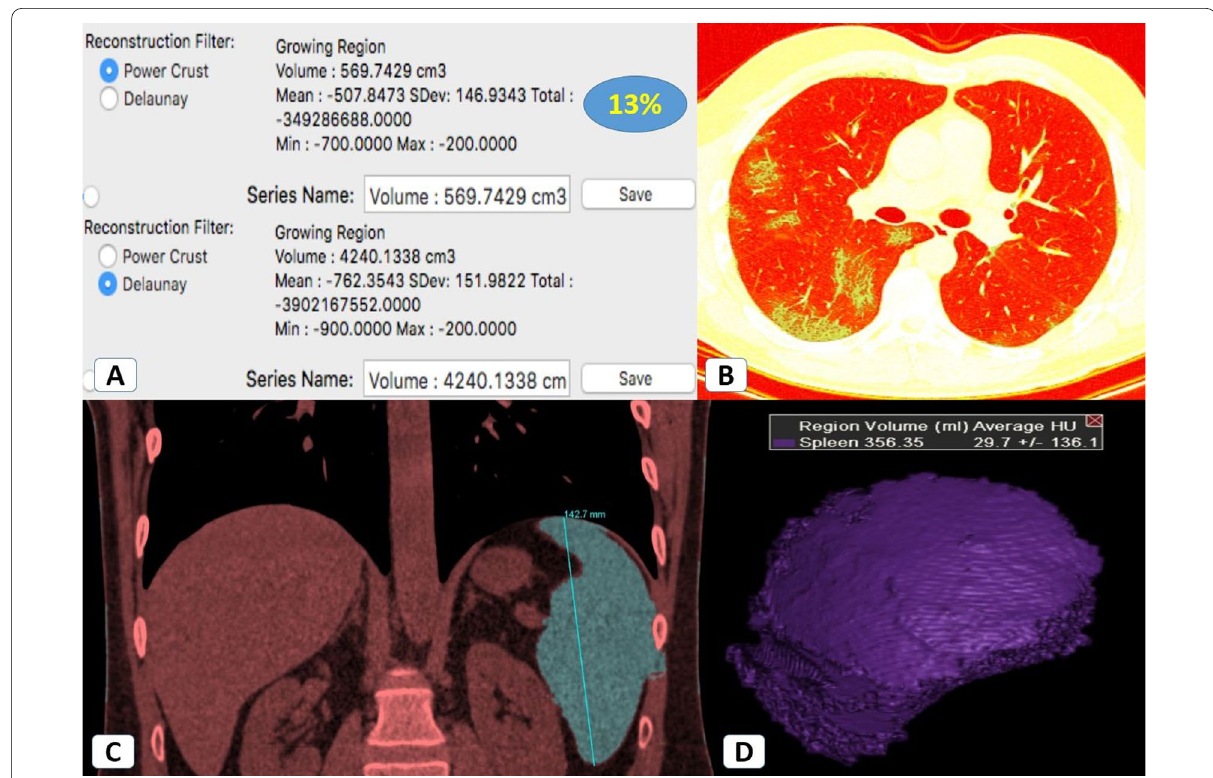
Fig. 3 Splenomegaly in a 33-year-old male patient with mild COVID-19 infection: A , B Volumetric CT assessment of the lung revealed 13% pathological lung involvement. C Coronal CT (mediastinal window) showed an increased craniocaudal bi-polar diameter of the spleen (14.2 cm). D CT volumetry of the spleen was 356